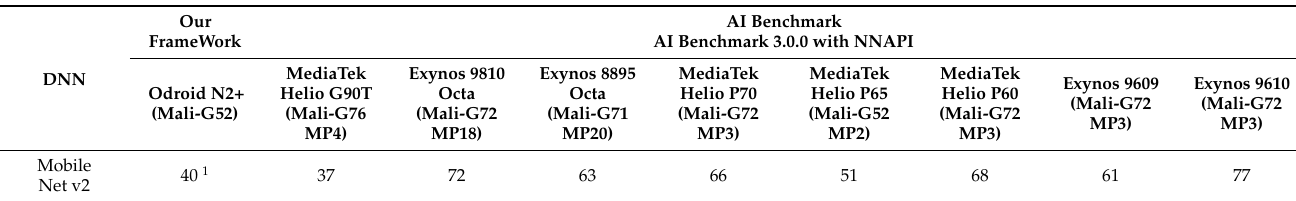
Table 7. Comparison of inference times (ms) of our framework and AI Benchmark. Our FrameWork DNN Odroid N2+